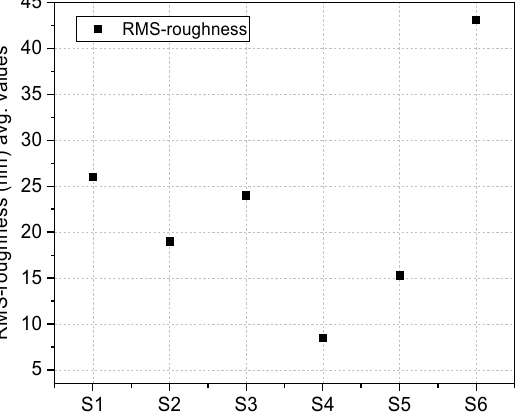
Figure 3. RMS surface roughness (nm) determination from 2D AFM images for multiple configura- tions of thin layer depositions; S6 film expressed the most excreased roughness.